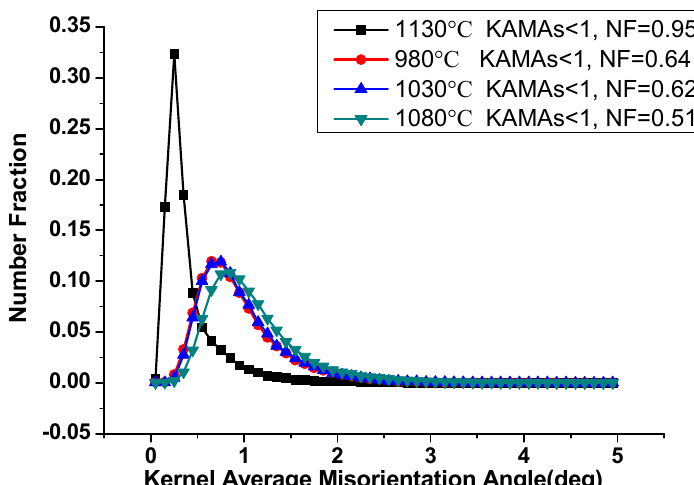
Figure 8. NF of KAMAs of 980 ◦ C / 1030 ◦ C / 1080 ◦ C / 1130 ◦ C.